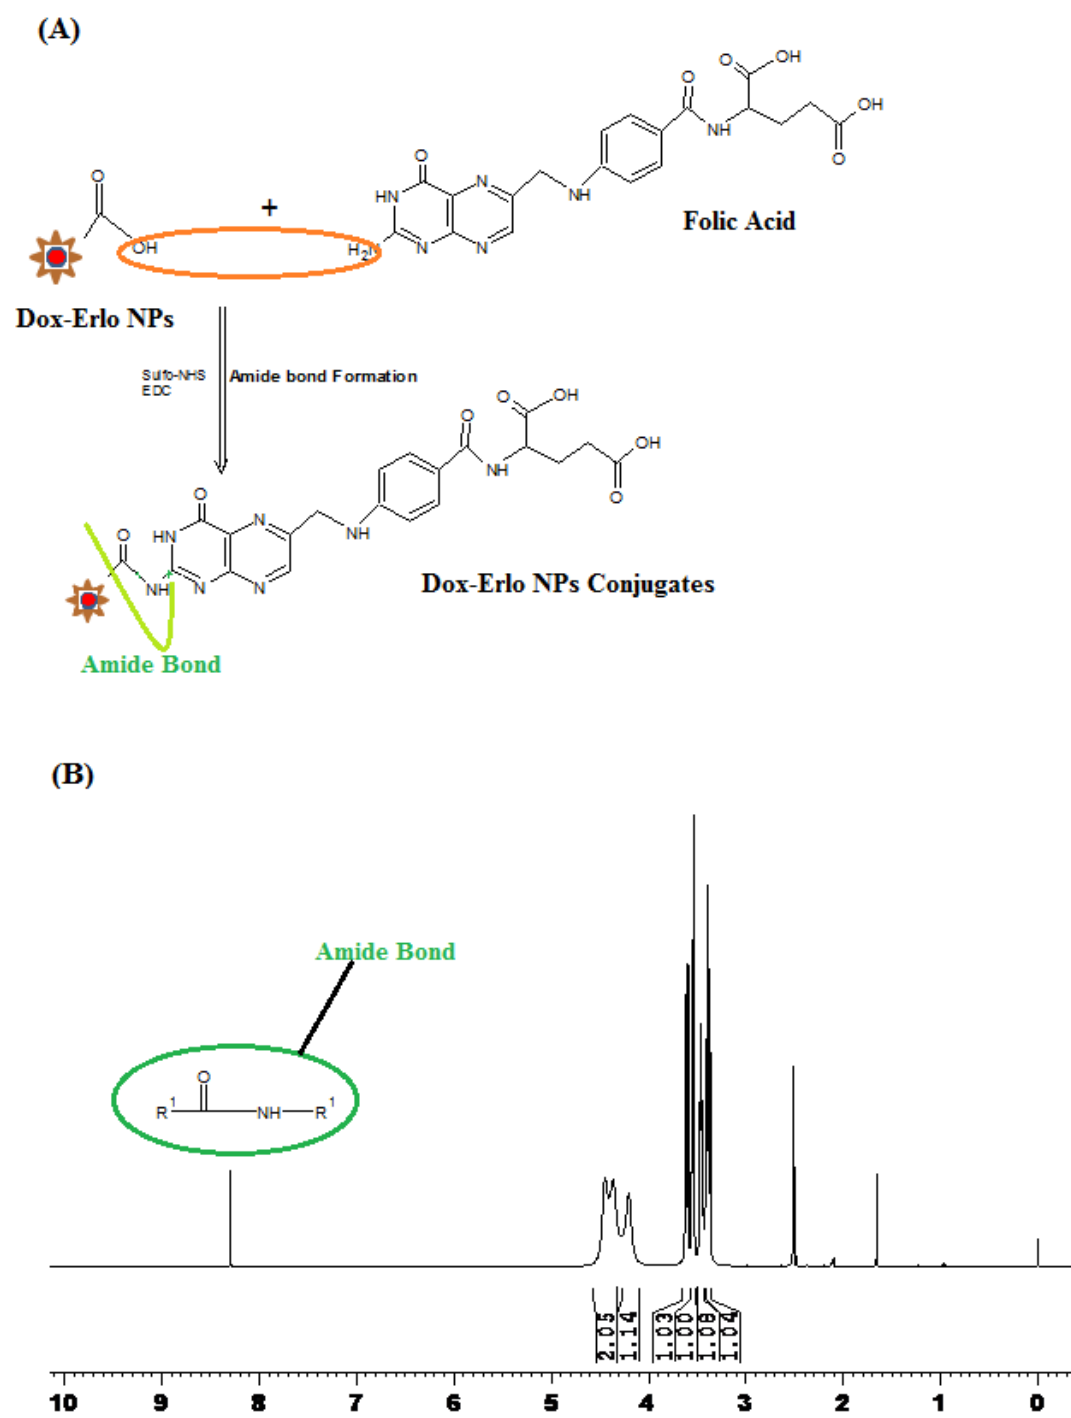
Figure 7. Schematic diagram of amide bond formation of Dox–Erlo NPs ( A ) and the 1 H NMR spectrum of Dox–Erlo-NP conjugates ( B ).